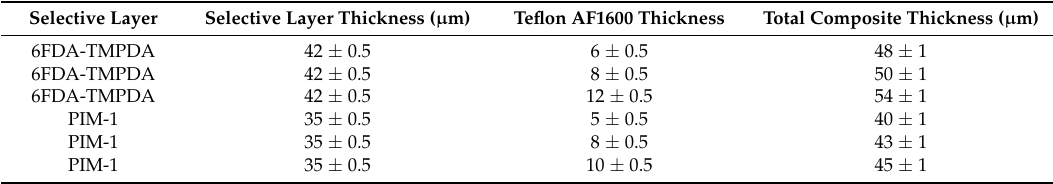
Table 1. Total thickness ( µ m) of composite PIM-1 and 6FDA-TMPDA membranes with various thickness of the Teflon AF1600 protective